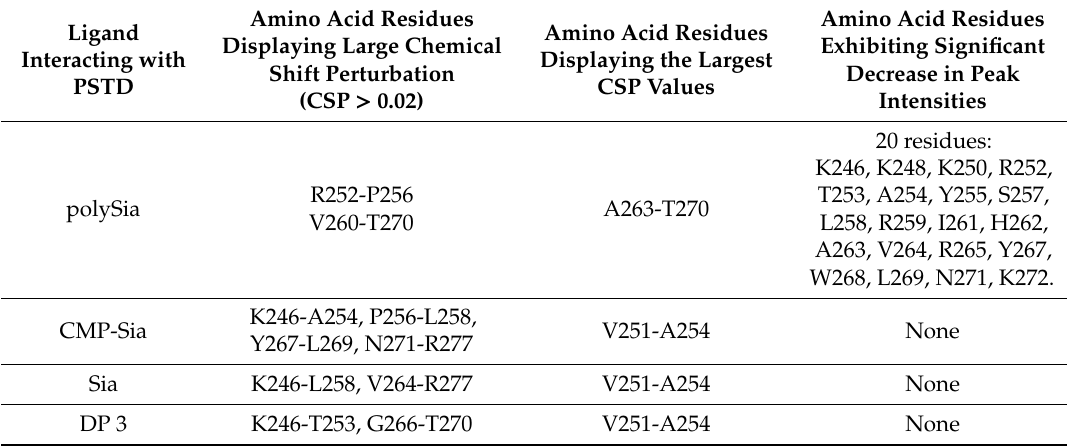
Table 1. Major features of the overlaid 1 H- 15 N HSQC spectra of PSTD in the absence and presence of Sia, TriSia, CMP-Sia and